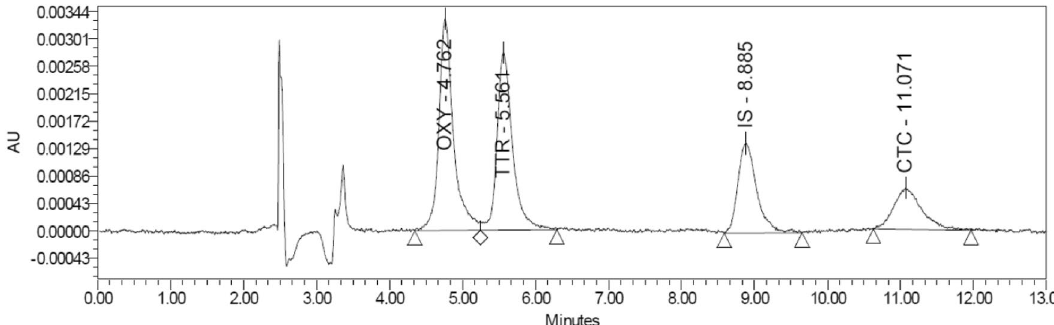
Figure 4. The chromatogram of the proposed method. Chromatographic conditions: 10 mM KH2PO4: ACN: MeOH (70:20:10), Injection volume: 50 µL, Temperature: 25 ℃ , Flow rate: 1 mL/min, Detection wavelength: 358